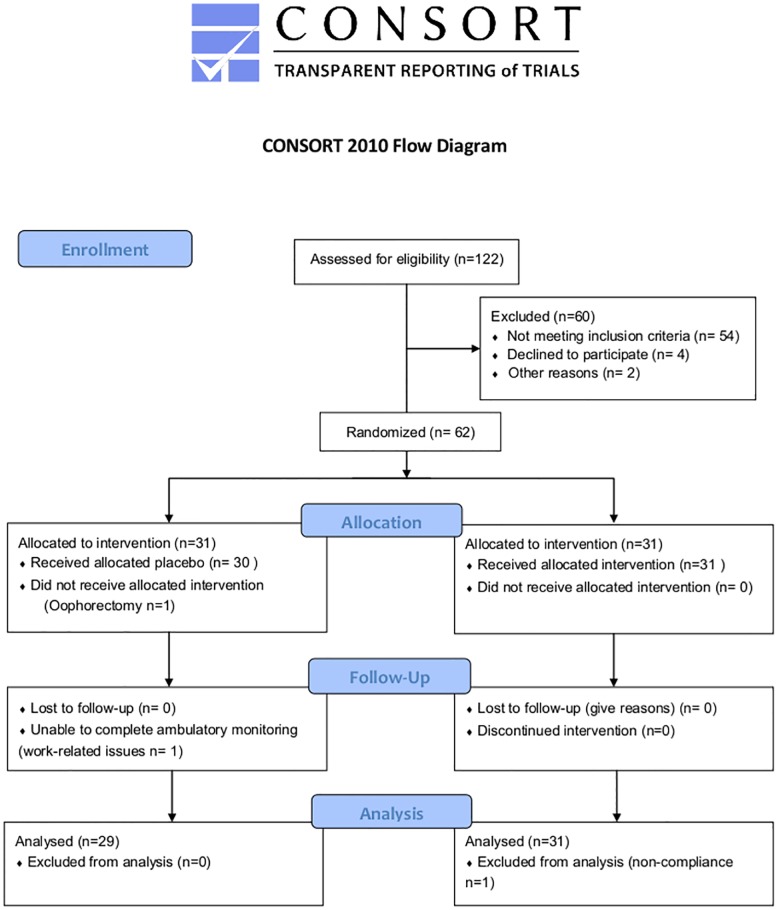
Consort diagram.In total 122 women were screened, 62 women met the inclusion criteria and were enrolled in the study. One participant dropped out due to personal reasons, two participants were excluded; one post medical examination due to undisclosed information regarding her physiological status and one submitted inadequate SC data due to lack of compliance during SC testing.